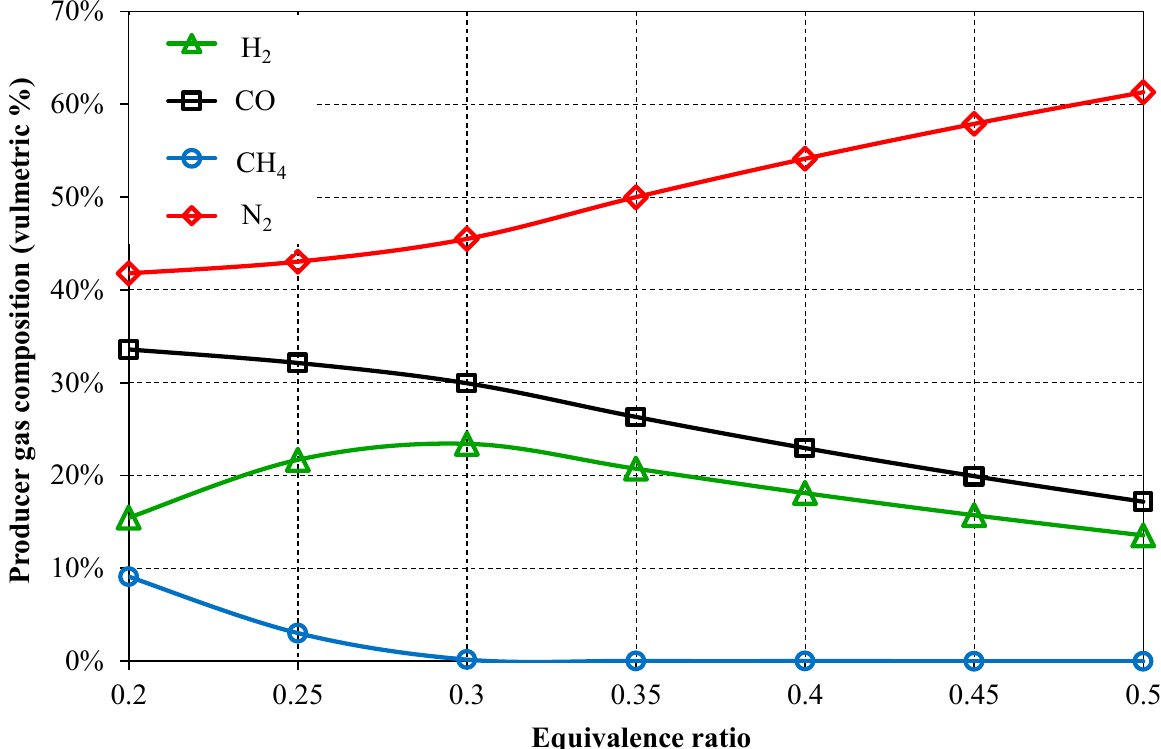
Figure 4. Effect of ER on the composition for air gasification.